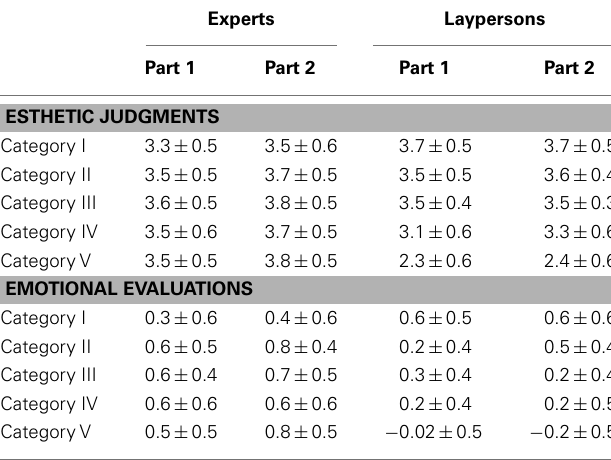
Table 2 | Mean ± SD ratings of esthetic judgments and emotional evaluations.